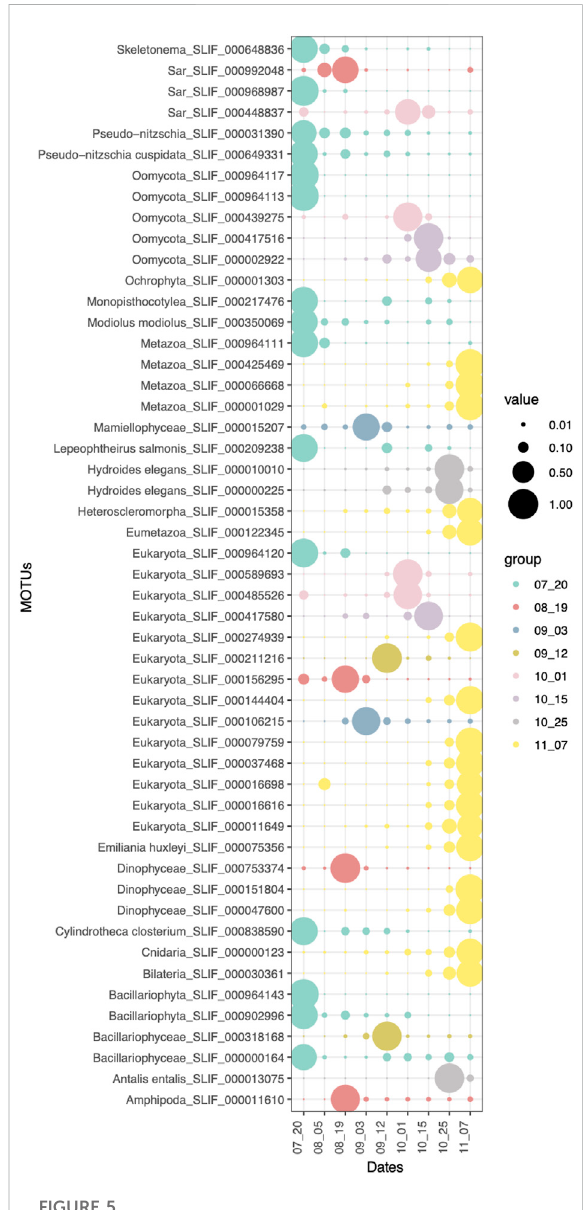
FIGURE 5 Indicator MOTUs( p -value < 0.05) ofeach sampling date. Size of the circles correspond to the relative abundances of each MOTU in each sample